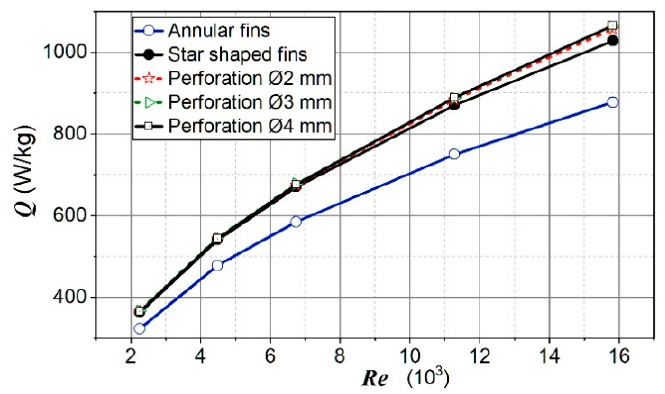
Figure 16. The heat transferred per unit of mass.